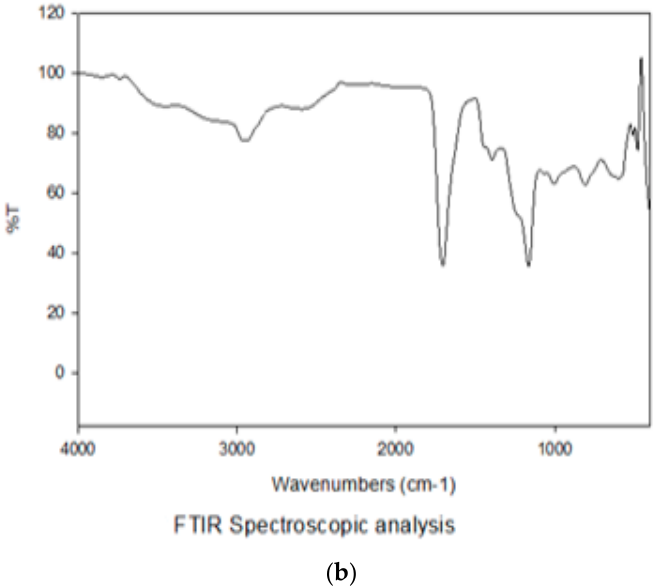
Figure 1. Characterization of Bacillus amyloliquefaciens-encapsulated nanoparticles using transmission electron microscopy ( a ) and Fourier-transform infrared spectroscopy ( b ).